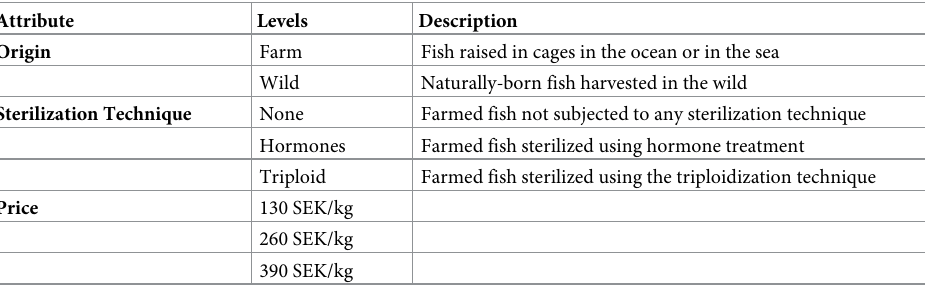
Table 3. Attributes and